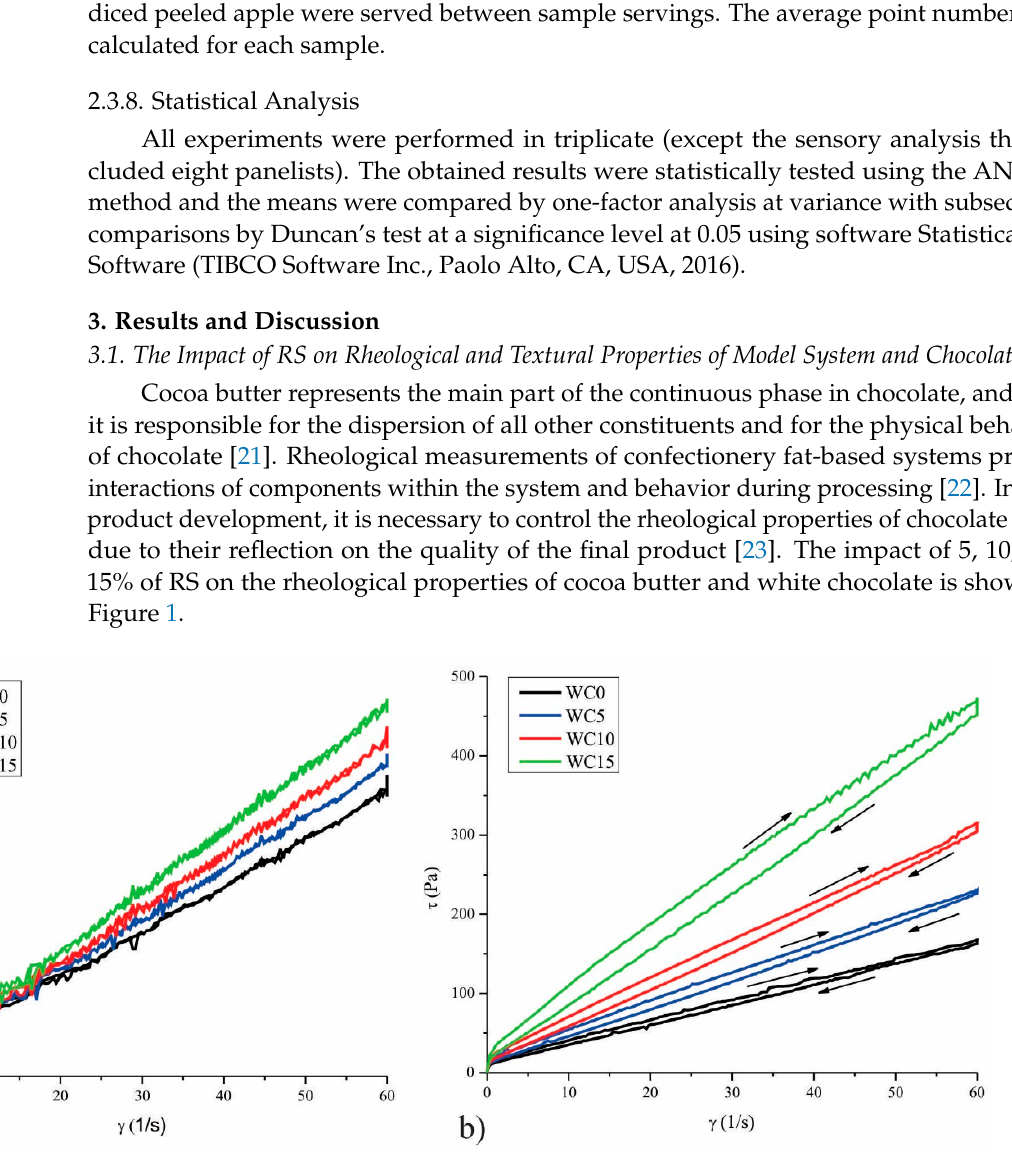
(Pa · s). The viscosity of the model system and rheological parameters of white chocolate are presented in Table